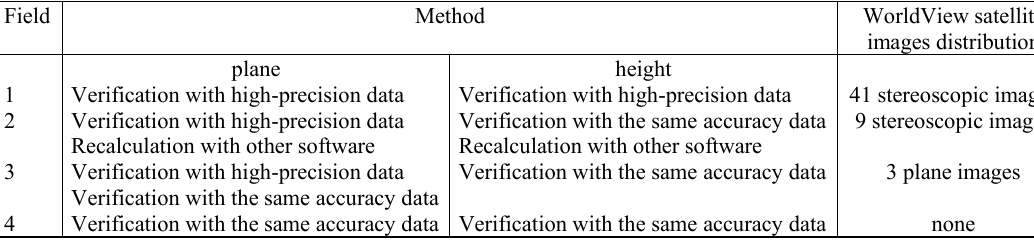
Table 4. Methods of test fields